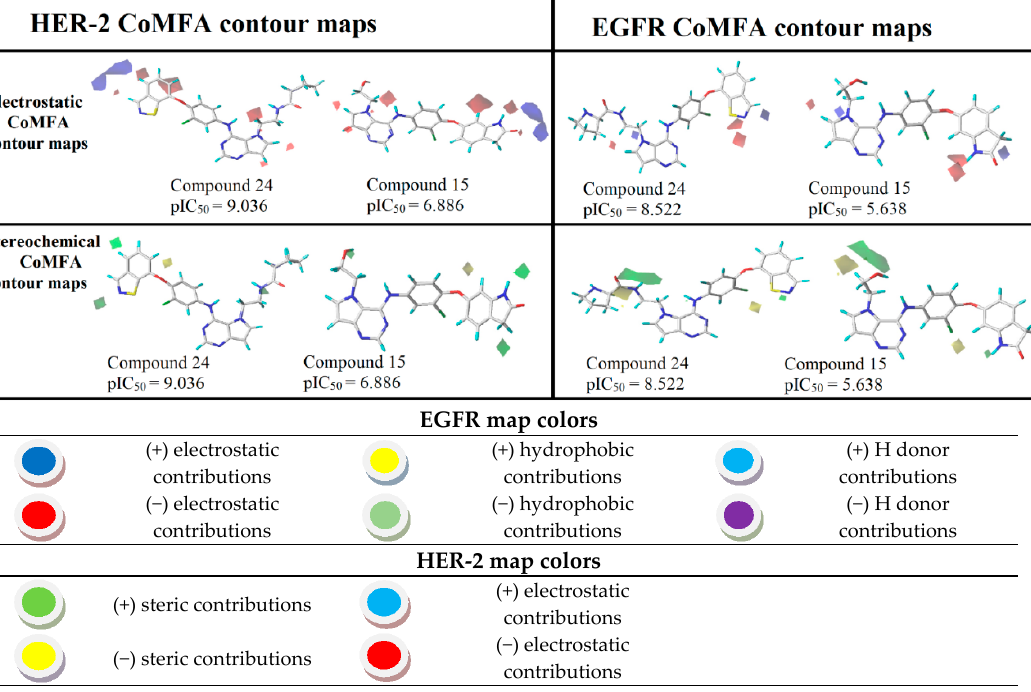
Figure 5. CoMFA contour maps for the most and the least active compounds (EGFR and